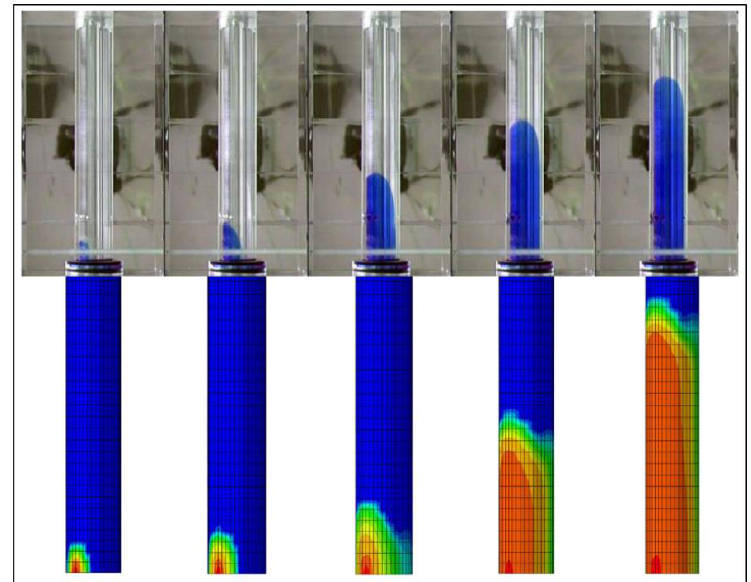
Figure 6. The comparation of numerical simulation and the Brice experiment.